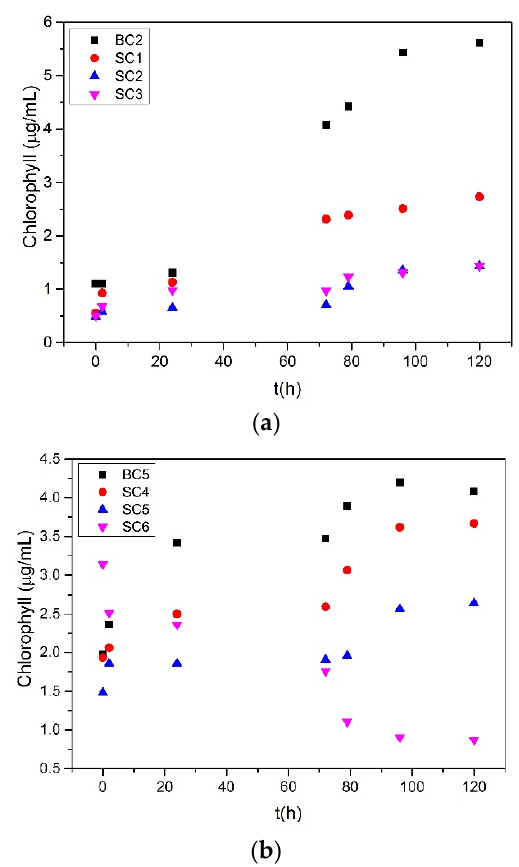
Figure 2. Total chlorophyll concentration time profile during the precipitation of calcium carbonate from supersaturated solutions, in the presence of zinc, under illumination in the presence of 10 mL of A. obliquus culture and nutrient medium, ( a ) Ca t = C t = 1.7 mM; ( b ) Ca t = C t = 3.4 mM; 25 °C, pH initial 8.50, 0.15 M of NaCl.